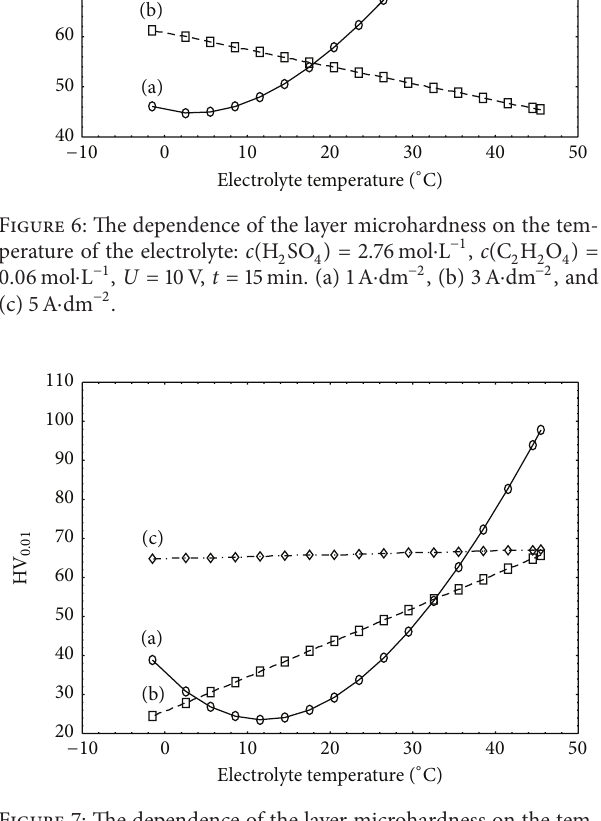
Figure 9: The dependence of the layer microhardness on the tem- perature of the electrolyte: c (H 2 SO 4 ) = 1.43mol ⋅ L −1 , c (C 2 H 2 O 4 ) = 0.06 mol ⋅ L −1 , U = 10V, t = 48.78 min. (a) 1A ⋅ dm −2 , (b) 3 A ⋅ dm −2 , and (c) 5A ⋅ dm −2